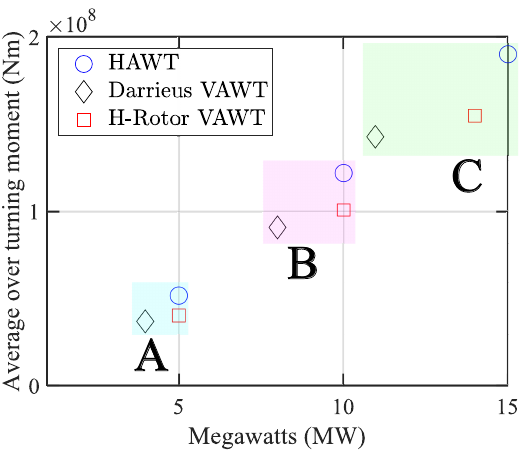
Figure 9. Average overturning moments (OTMs) for clusters A, B, C corresponding to medium, large and very large-scale turbines, respectively. Each cluster considers a HAWT, a Darrieus and a H-rotor turbines, whose dimensions are provided in Appendix